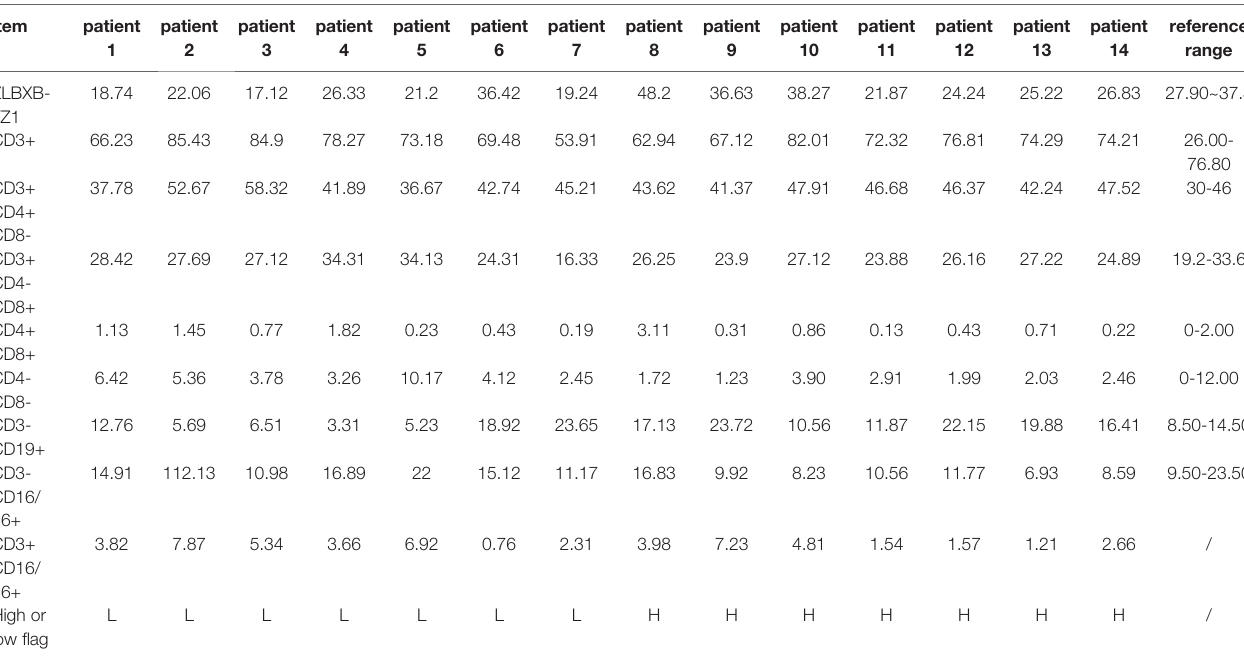
TABLE 1 | Results of immune function quality of patients in different